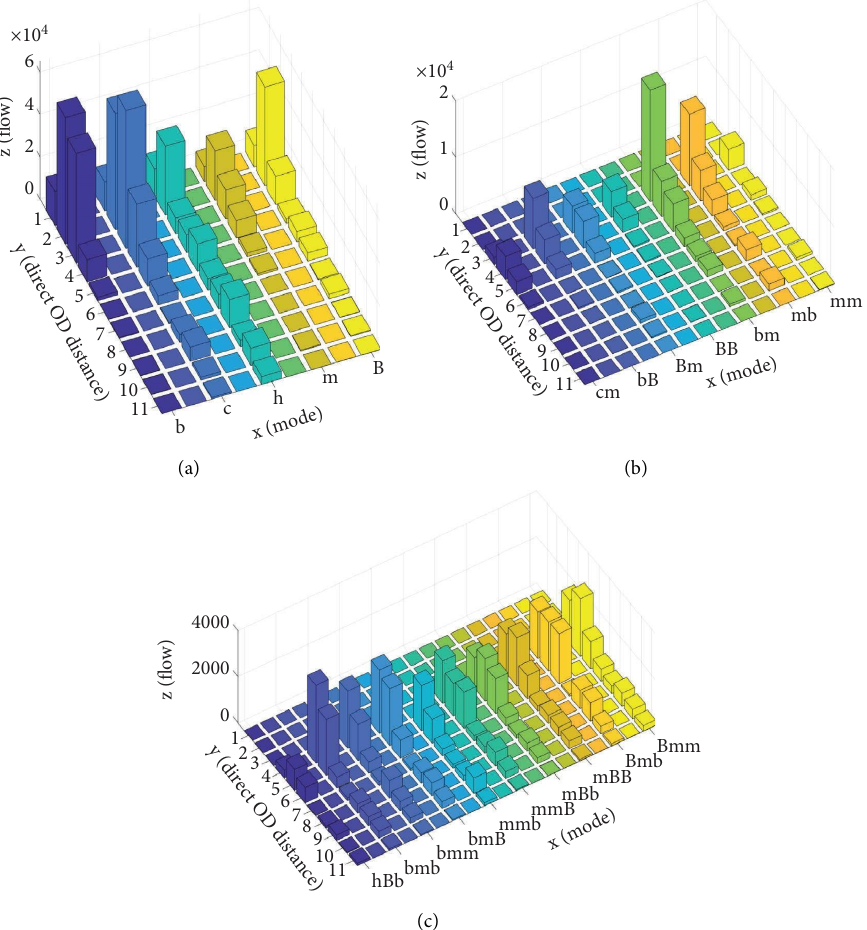
Figure 17: Mode fow of the solution. (a) Single-mode fow. (b) One transfer mode fow. (c) Two transfers mode